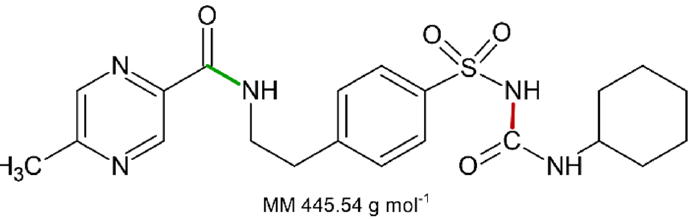
Figure 3. Molecular structure of GPZ . The two chemical bonds that could be subjected to breaking are colored in red and green.